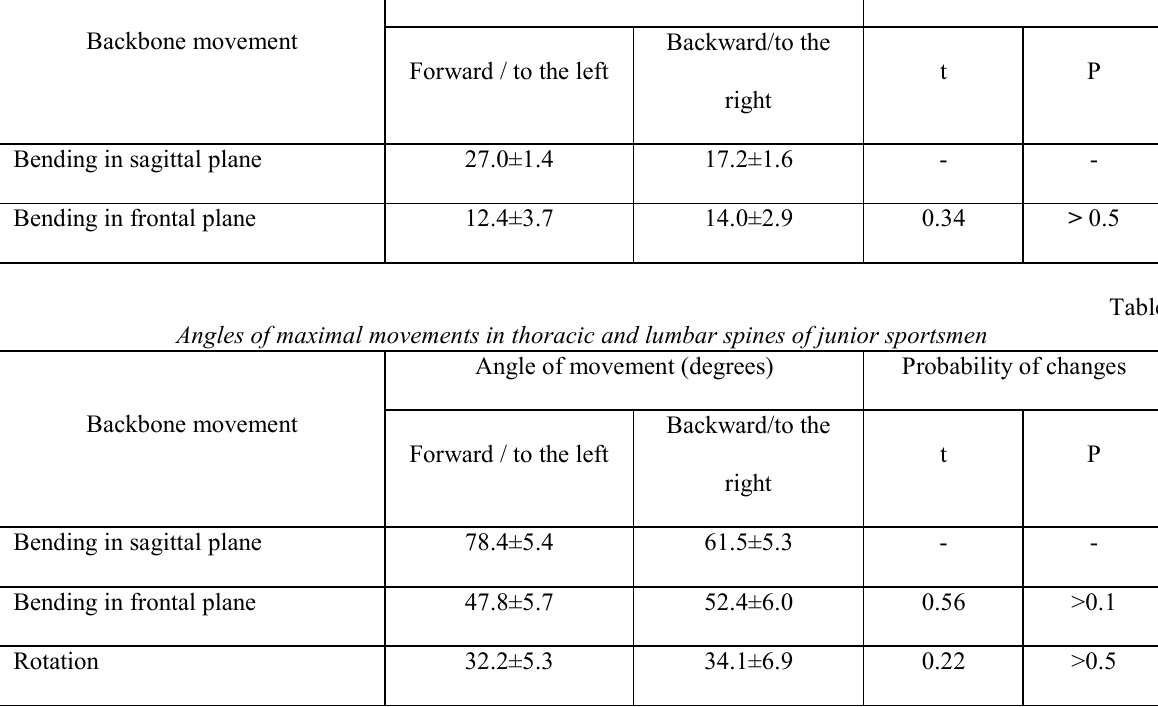
Angles of maximal movements in thoracic spine of junior sportsmen Angle of movement (degrees) Probability of changes